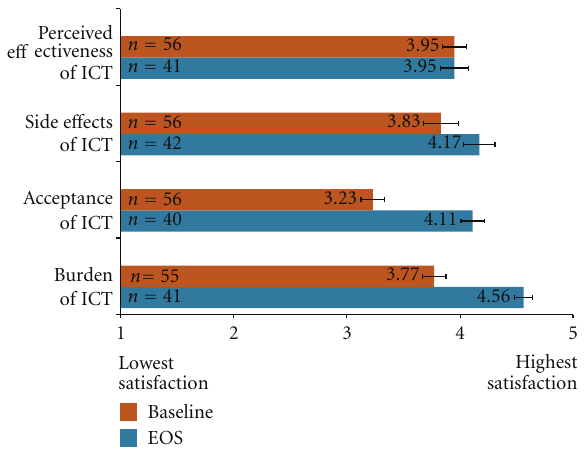
Figure 4: Mean SICT domain scores at baseline and EOS for MDS population with prior history of